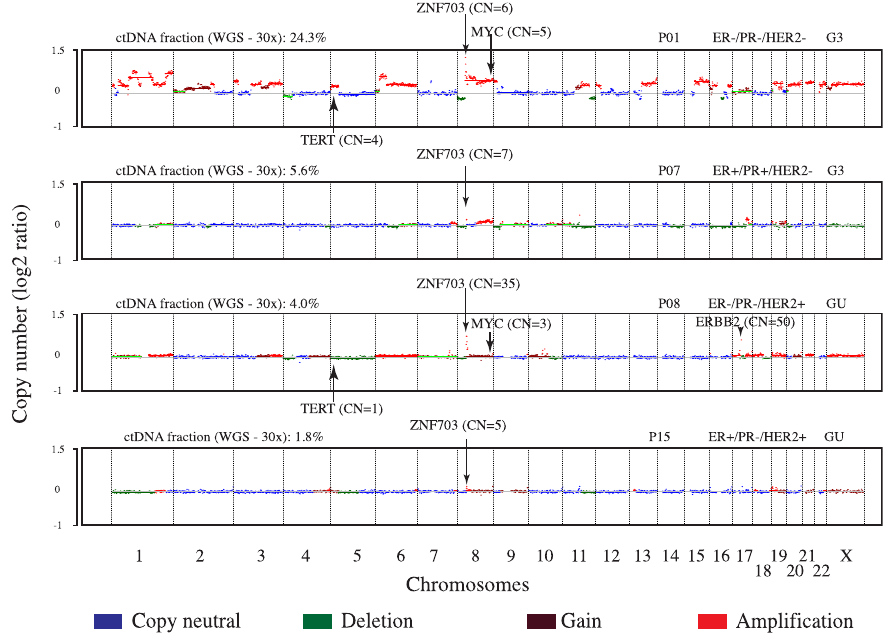
Fig. 2 Genome-wide copy number pro fi les of 4 patients from cfDNA sequenced at 30× WGS. The x -axis represents chromosomes (chr1-22: X) and y -axis shows log2 copy number. Blue represents copy neutral, i.e., chromosomal loci with standard 2 copies (such as chr3, chr4, and chr5 in P07). Deletions of genomic loci (i.e., chr4p in P01 and P08) are shown in green. Gains (3 – 4 copies) and ampli fi cations (>4 copies) of chromosomal loci (such as chr8p12 containing ZNF703 genes in P01, P07, P08, and P15) are shown in brown and red colors, respectively. P08 has ampli fi cation of the chr17 locus containing ERBB2 . Arrows indicate the gene and estimated copy number (CN) of the predicted segment by ichorCNA. GU Grade Unknown, G2 moderately differentiated, G3 poorly differentiated, WGS whole-genome sequencing, CN copy number, ER estrogen receptor, PR progesterone receptor, HER2 human epidermal growth factor receptor 2, ctDNA circulating-tumor